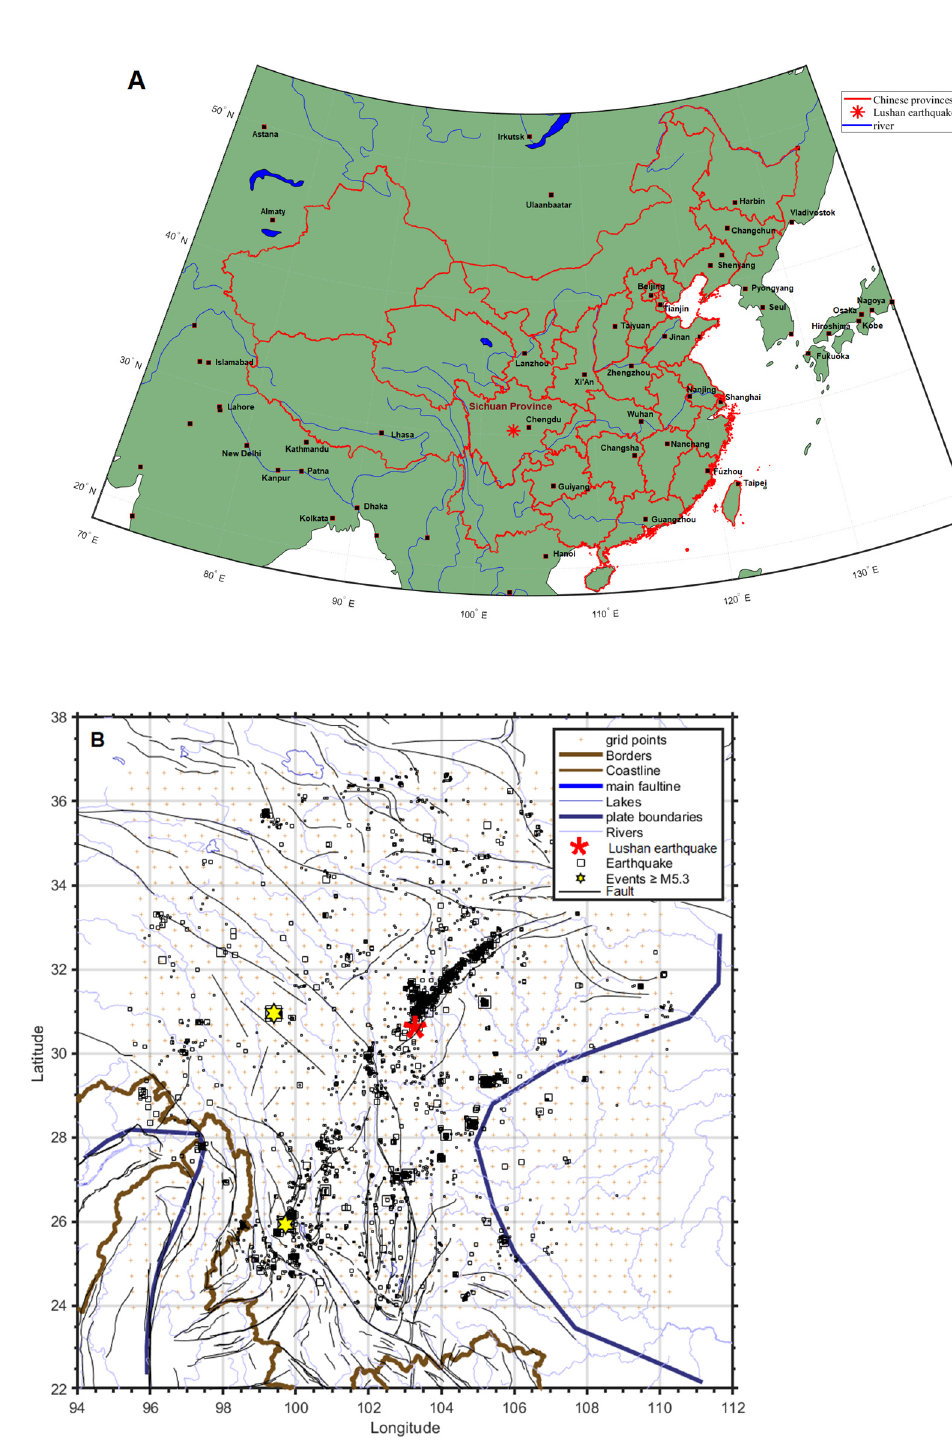
Figure 1. Geographical location of the Lushan earthquake within China ( A ) and map of seismic events ( B ) within the Dobrovolsky radius from 22 October 2012 to 20 April 2013 (events before the Lushan earthquake). Yellow stars represent earthquakes with a magnitude M ≥ 5.3. The Lushan 2013 earthquake is marked by a red asterisk.